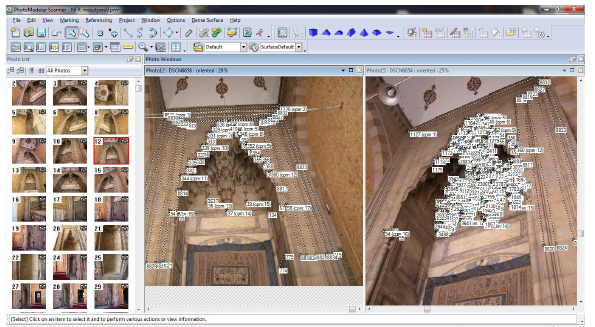
Figure 3. Stereo photogrammetric processes